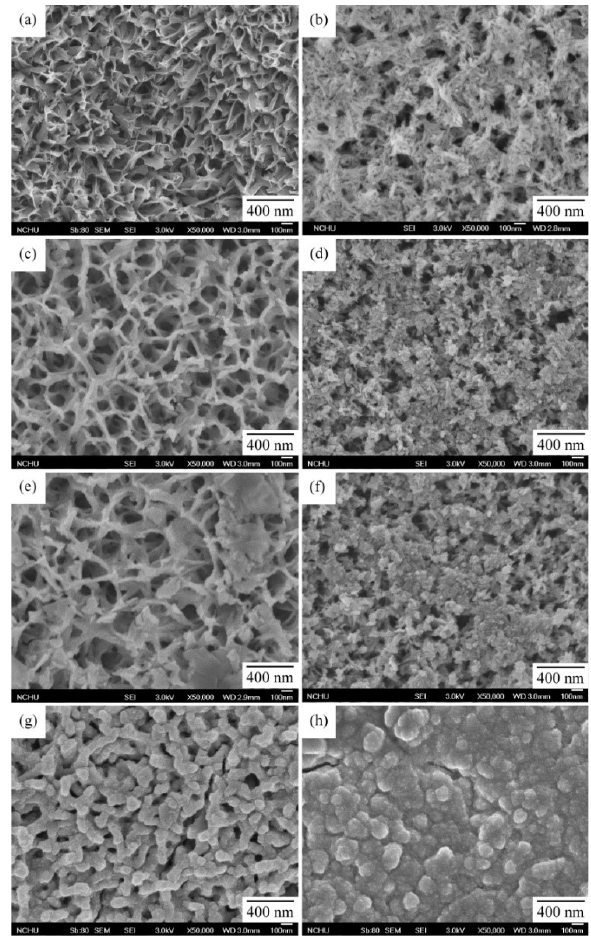
Figure 6. FE-SEM photographs of the surfaces of NaOH-treated c.p. Ti ( a , c , e , g ) and HA-coated c.p. Ti samples ( b , d , f , h ) that were subjected to heat treatment at 500 °C for 2 h after subsequent soaking in SBF for 6, 12 and 24 h, respectively.